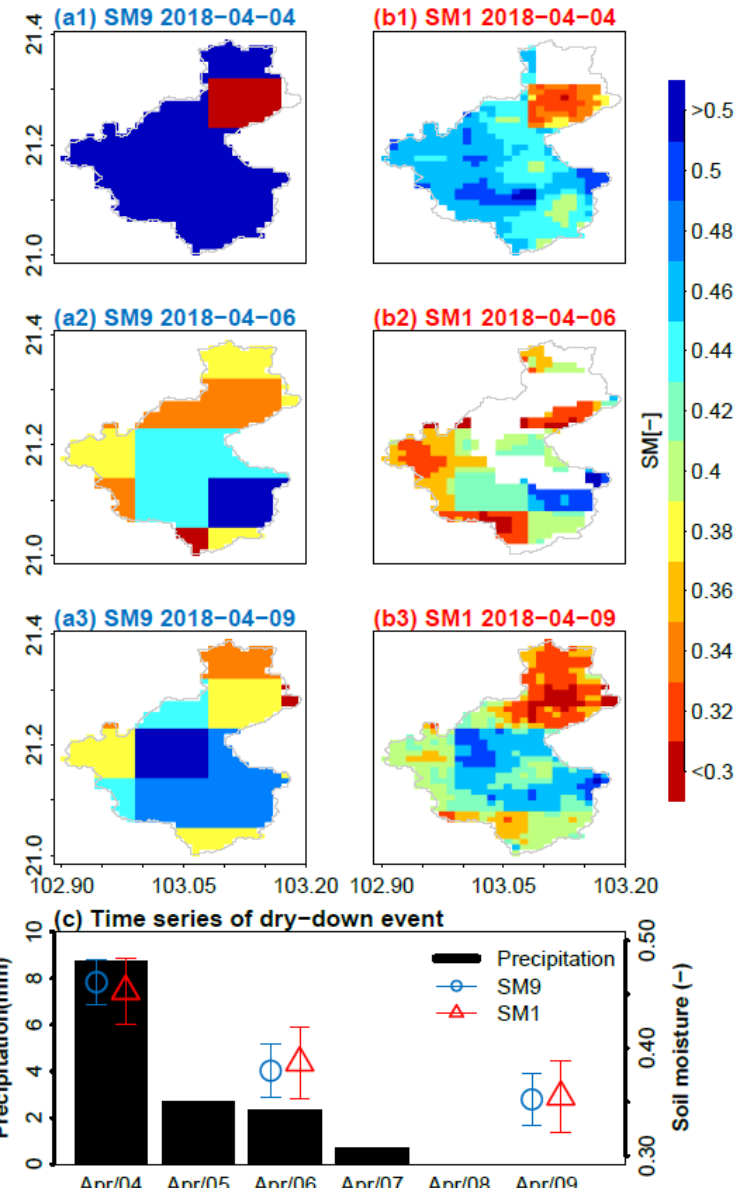
Figure 5. Spatial variation in a dry-down event in bye catchment from April 4, 2018, to April 9, 2018, with soil moisture SMAP 9 km (SM9, ( a1 , a2 , a3 )), soil moisture SMAP 1 km (SM1, ( b1 , b2 , b3 )), and ( c ) time series of dry-down event at the same period from GPM IMERG (black bar) and SM9 (blue) and SM1 (red). The error bars indicate standard deviation of SM variation in the catchment.